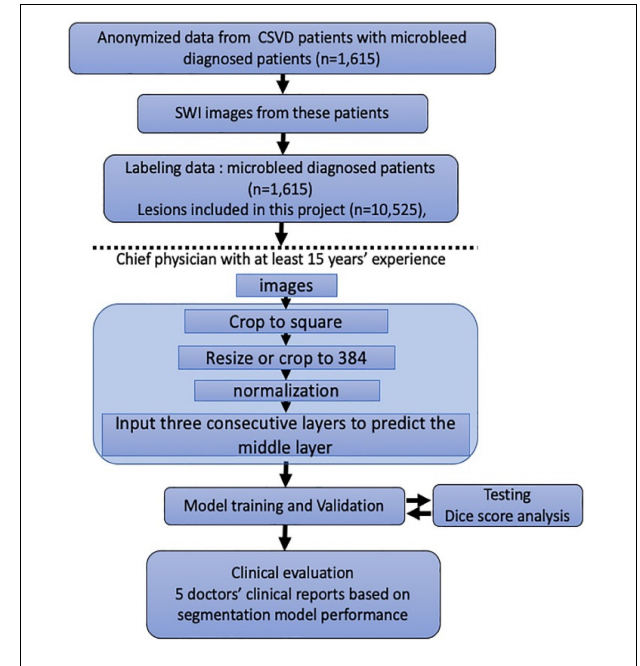
FIGURE 2 | Flowchart of the patients’ distribution in training and clinical evaluation sets. Model training and clinical evaluation steps use the distribution and classification of all samples in each